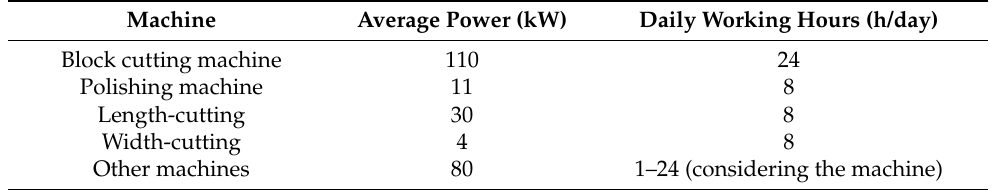
Table 5. Rated power and working hours of typical machines in a middle-sized stonecutting